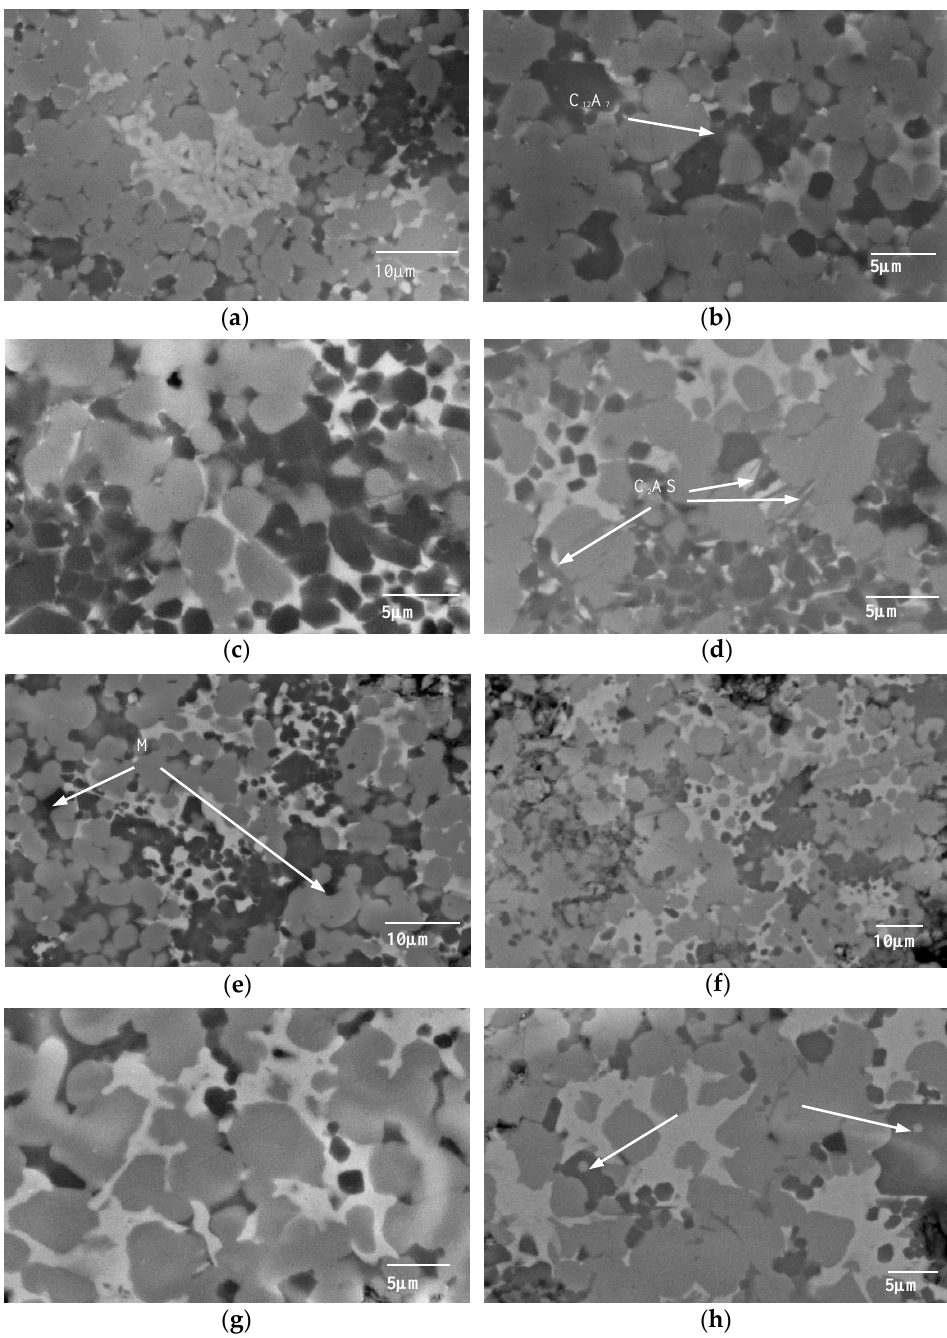
Figure 5. SEM / BSE microphotographs of the investigated clinkers. ( a ) Clusters of ferrite crystals, air-quenched clinker; ( b ) mayenite dark interstitial phase, air quenched clinker; ( c ) six-sided calcium sulfoaluminate crystals, nonlinearly cooled clinker; ( d ) needle-like gehlenite, linearly cooled clinker; ( e ) periclase grain, nonlinearly cooled clinker; ( f ) poikilitic texture, slowly cooled clinker; ( g ) irregular shaped belite, slowly cooled clinker; ( h ) calcium sulfoaluminate enclosing belite crystal, slowly cooled clinker.